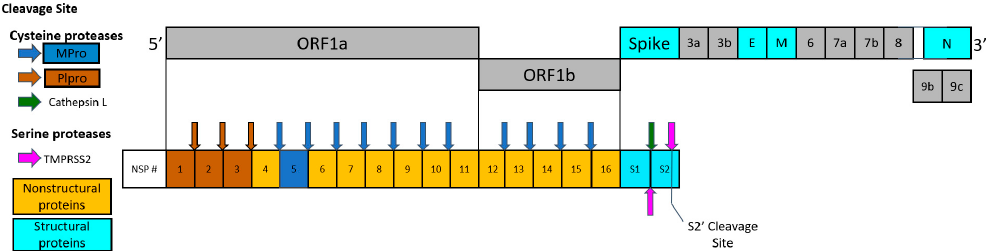
Figure 1. Schematic drawing of polypeptides expressed by SARS-CoV-2, including nonstructural proteins (NSPs), structural proteins, and accessory proteins. Each represented viral protein is not drawn to actual scale. Brown and blue arrows represent the cleavage sites of SARS-CoV-2 Mpro and PLpro, respectively. Cathepsin L cleavage between S1/S2 subunits is represented by the green arrow. The cleavage sites of TMPRSS2 located between S1/S2 subunits and S’ cleavage site in S2 subunit are indicated by magenta arrows.